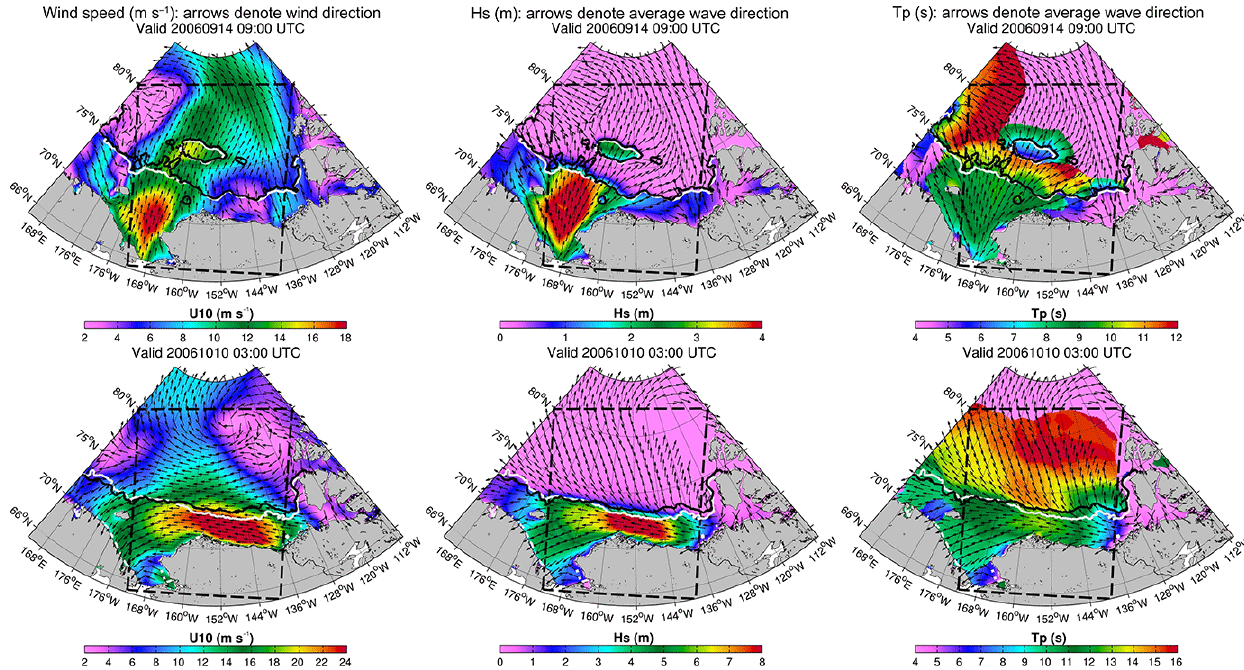
Figure 13. Wind speeds, significant wave heights, and peak periods for events in September and October 2006. The arrows denote the wind direction or average wave direction. The contour lines represent the 15% ice concentration before (white) and after (black) the